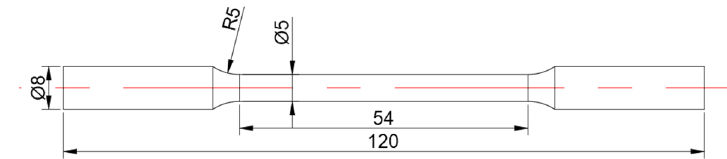
Figure 1. Slow strain rate tensile test specimen (/mm).